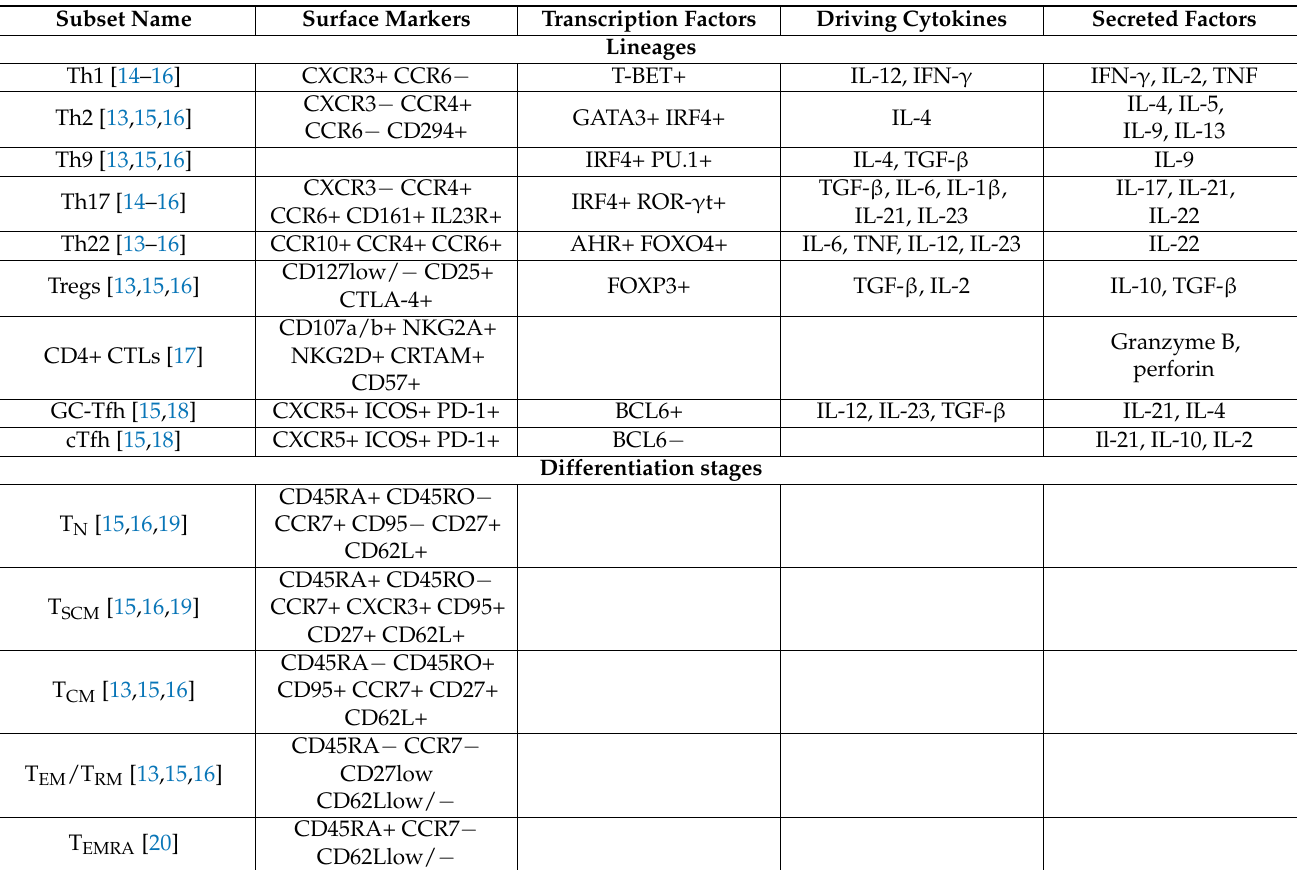
Table 1. Main CD4+ T cell subsets: markers, cytokines driving their differentiation, and effector